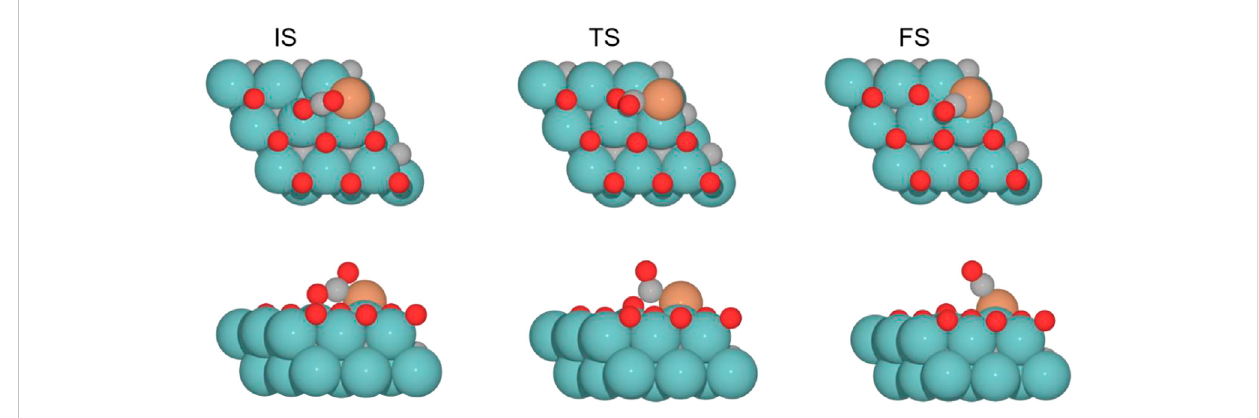
FIGURE 9 Top and side views of the initial state (IS), transition state (TS), and fi nal state (FS) catalyzed by the Cu/Mo 2 C of 0.78 ML system for the CO 2 cleavage (see Supplementary Figures S7-9 for the structures of other intermediates and TS on 0, 0.33, and 0.67 O* ML